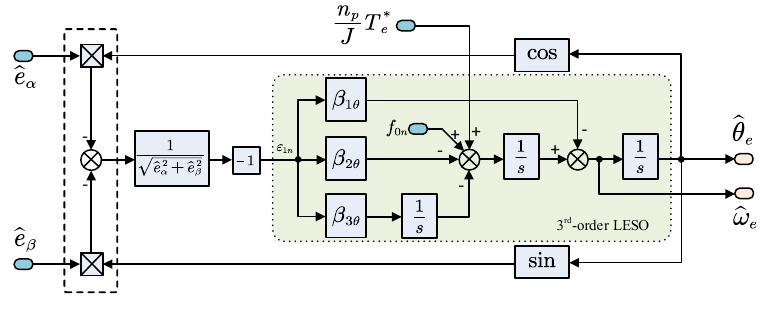
Figure 2. Block diagram of the LESO-based QPLL.